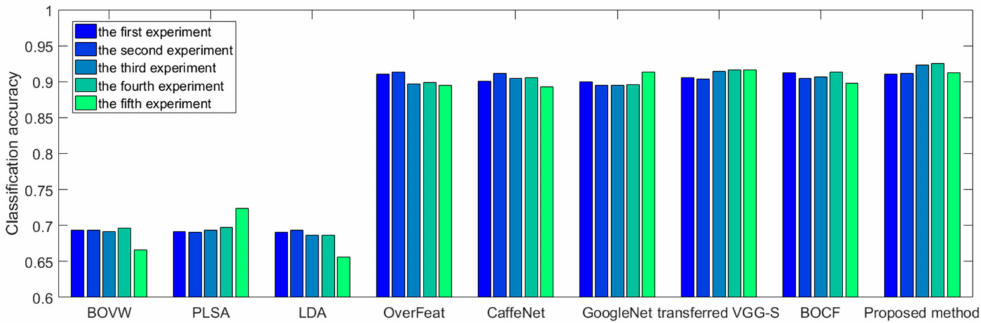
Figure 14. The classification accuracy of five experiments on the proposed method and the state-of-the-art methods in the SIRI-WHU